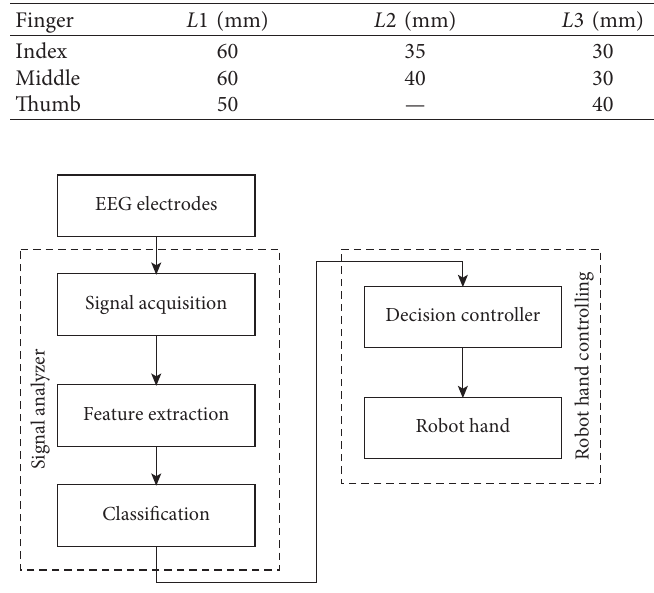
Figure 8: Architecture of the signal analyzer and decision controller.